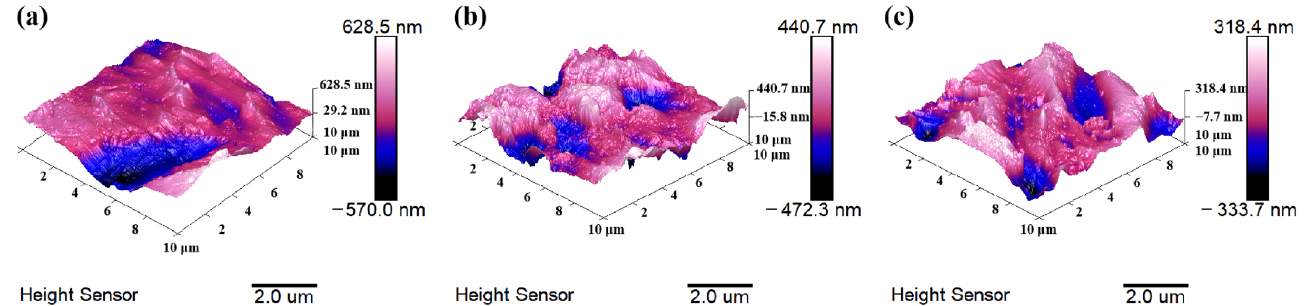
It is evident that the erosion surface of the coating exhibits typical ductile erosion